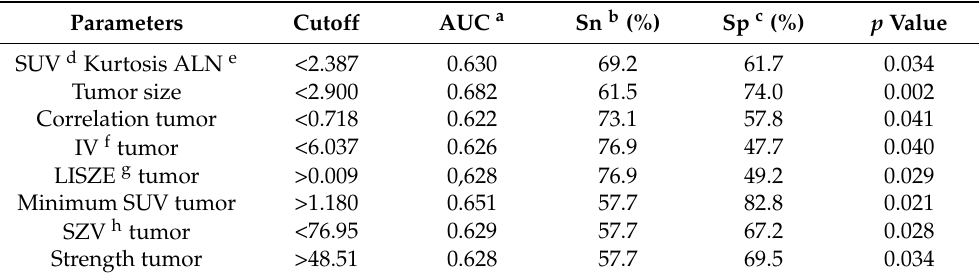
Table 4. ROC analysis of the significant clinical and textural parameters to identify pathologic complete response.